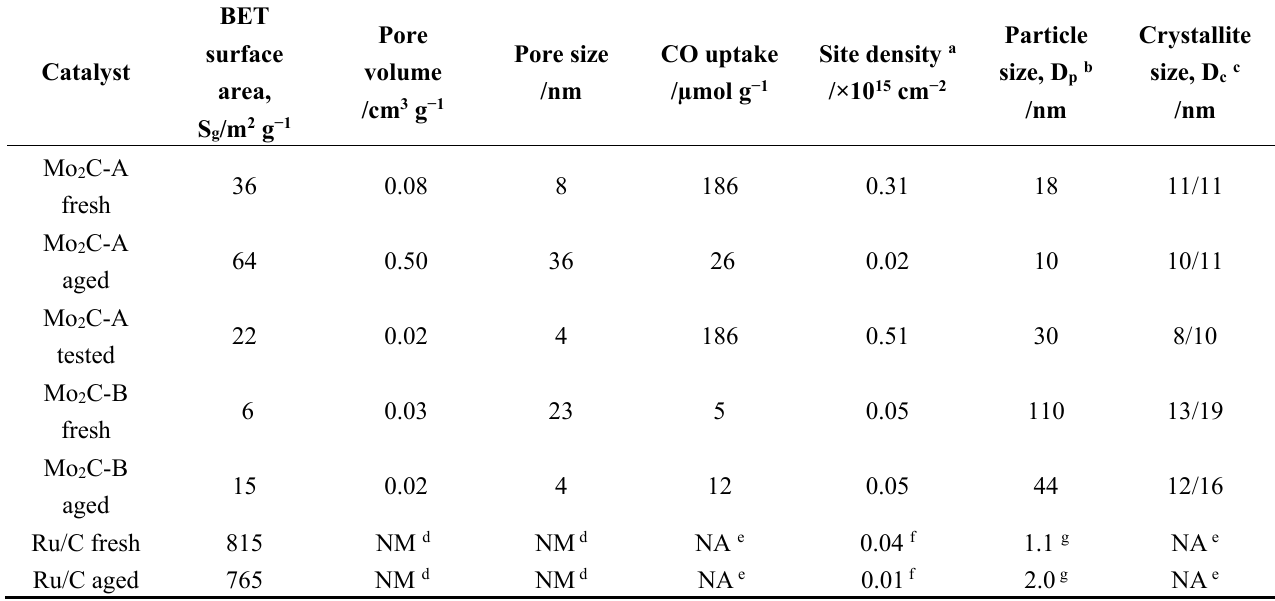
Table 1. BET surface area, pore volume, pore size, CO uptake, density of sites, particle size and crystallite size of the catalysts studied.